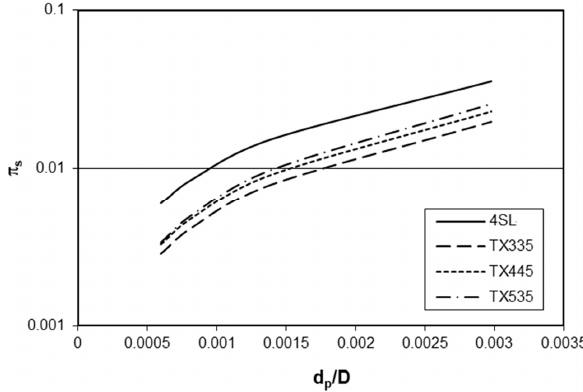
Figure 13. Dependence of the dimensionless power required to achieve the just-suspended state of particles of hydrofoil impellers TECHMIX on the dimensionless particle diameter d p / D for the mean volumetric concentration of the solid phase c v = 15% [34].